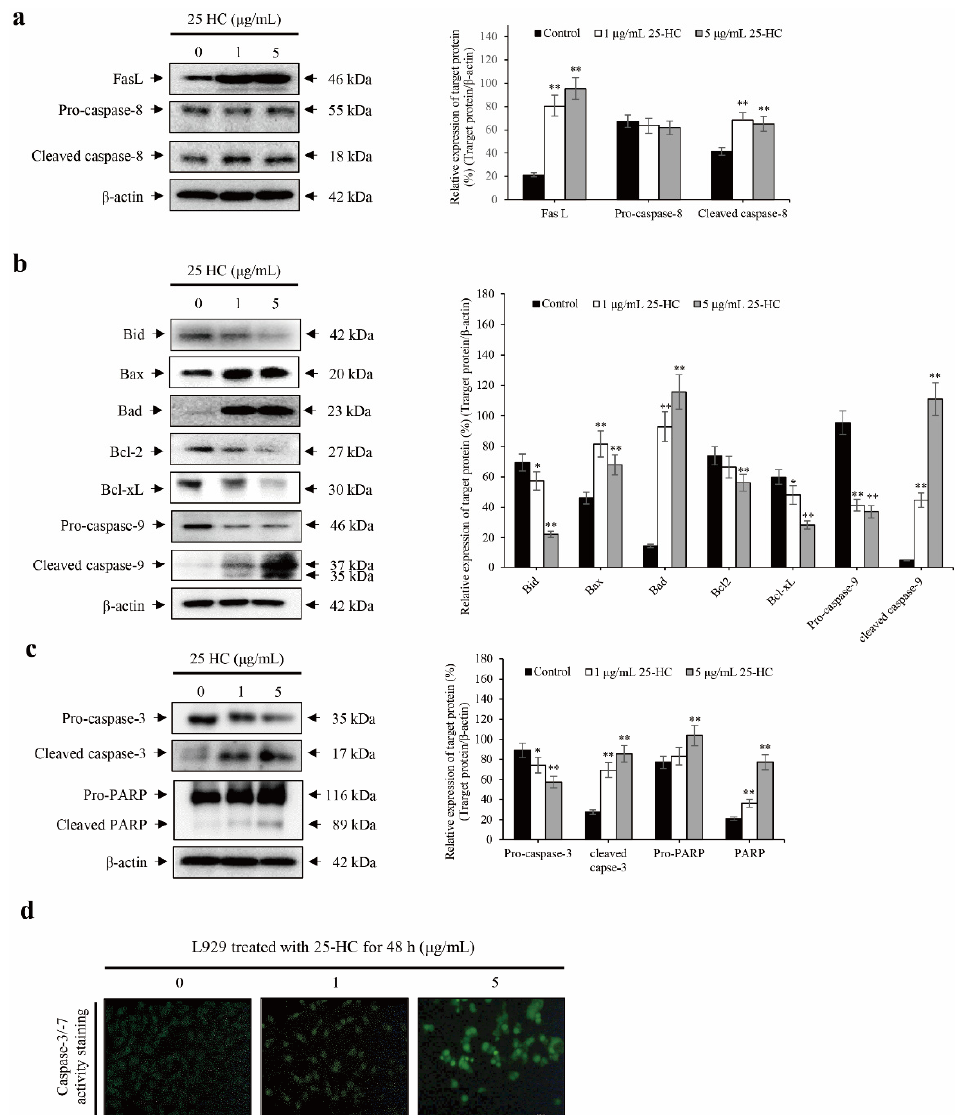
Figure 5. 25-HC-induced cell death was mediated by the cascade activation of caspases through the death receptor-mediated extrinsic and mitochondria-dependent intrinsic apoptosis pathways in L929 cells. L929 cells were treated with 1 and 5 µ g/mL 25-HC for 48 h. Thereafter, total proteins were extracted and electrophoresed on the SDS-PAGE gels to perform Western blot using specific antibodies associated with pro- and antiapoptotic factors. The results were expressed as the relative ratio of target protein/ β -actin, * p < 0.05 and ** p < 0.01. β -actin was used as the internal control. In addition, the activity of caspase-3 was assessed by staining the cell-permeable fluorogenic substrate PhiPhiLux-G 1 D 2 in L929 cells treated with 1 and 5 μ g/mL 25-HC for 48 h. L929 cells were treated with 1 and 5 μ g/mL 25-HC for 48 h. ( a ) Thereafter, 25-HC upregulated the expression of FasL and caspase-8, which are proapoptotic factors associated with death receptor-mediated extrinsic apoptosis in L929 cells. ( b ) 25-HC not only decreased the expression of antiapoptotic factors such as Bcl-2 and Bcl-xL, but also increased the expression of proapoptotic factors such as Bax, Bad, and caspase-9 in the mitochondria-dependent intrinsic apoptosis pathway in L929 cells. ( c ) Activated caspase-8 and -9 induced cell death through activation of caspase-3 and PARP in L929 cells. ( d ) There was a dose-dependent increase in the activity of caspase-3 in L929 cells treated with 25-HC.